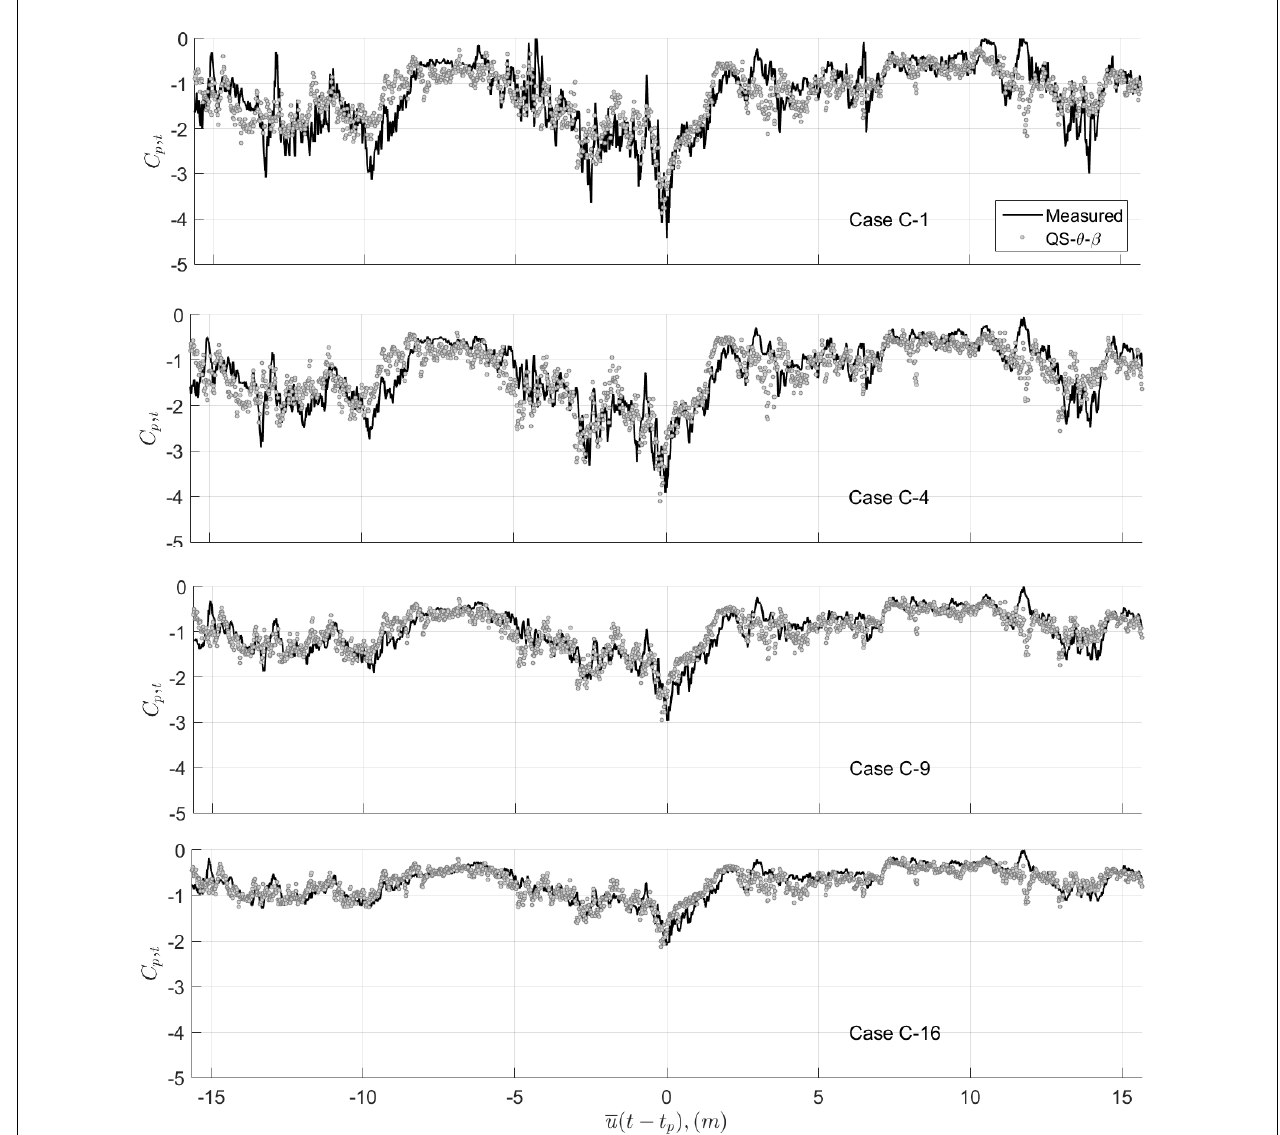
FIGURE 9 | Time series of measured and QS-predicted C p,t around a selected peak for cases C-1, C-4, C-9, and C-16, mean wind azimuth (cid:22) θ (cid:22) θ (cid:22) θ =